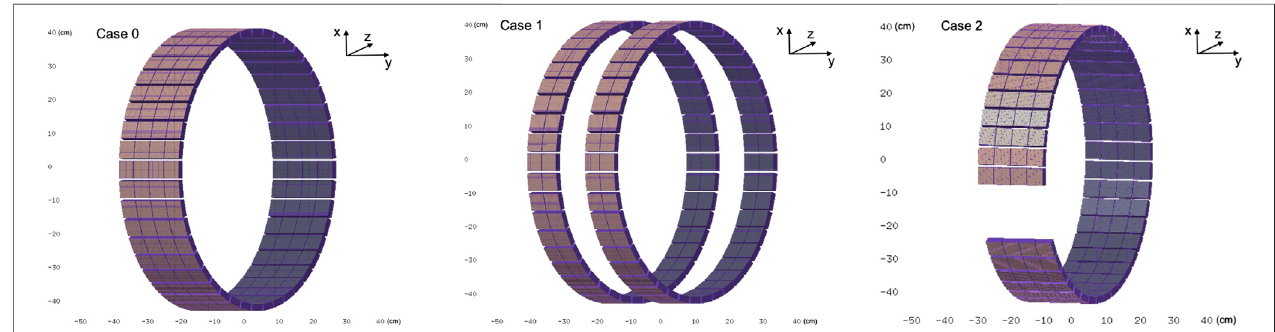
FIGURE 4 | Solid model of the proposed PET detector geometries to be integrated within the GaToroid system. Case 0: single ring geometry, reference. Case 1: staticdualringopengeometry,withthePETdetectorspositionedoneachsideofthebeamentrancewindows.Case2:dynamicsingleringgeometry,tobemountedon a rotating structure inside the gantry, with a gap for the beam